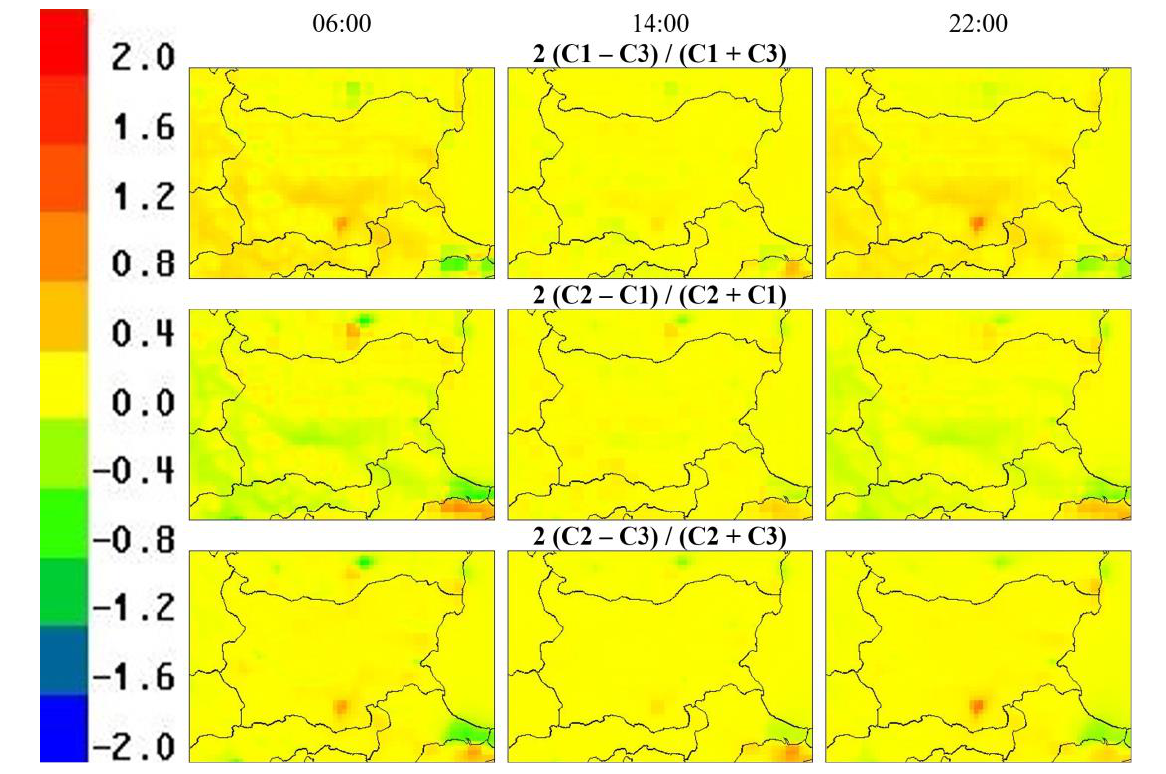
Figure 6. Annually averaged relative differences of the surface concentrations of O 3 between cases C1 and C3, C2 and C1, C2 and C3 respectively.